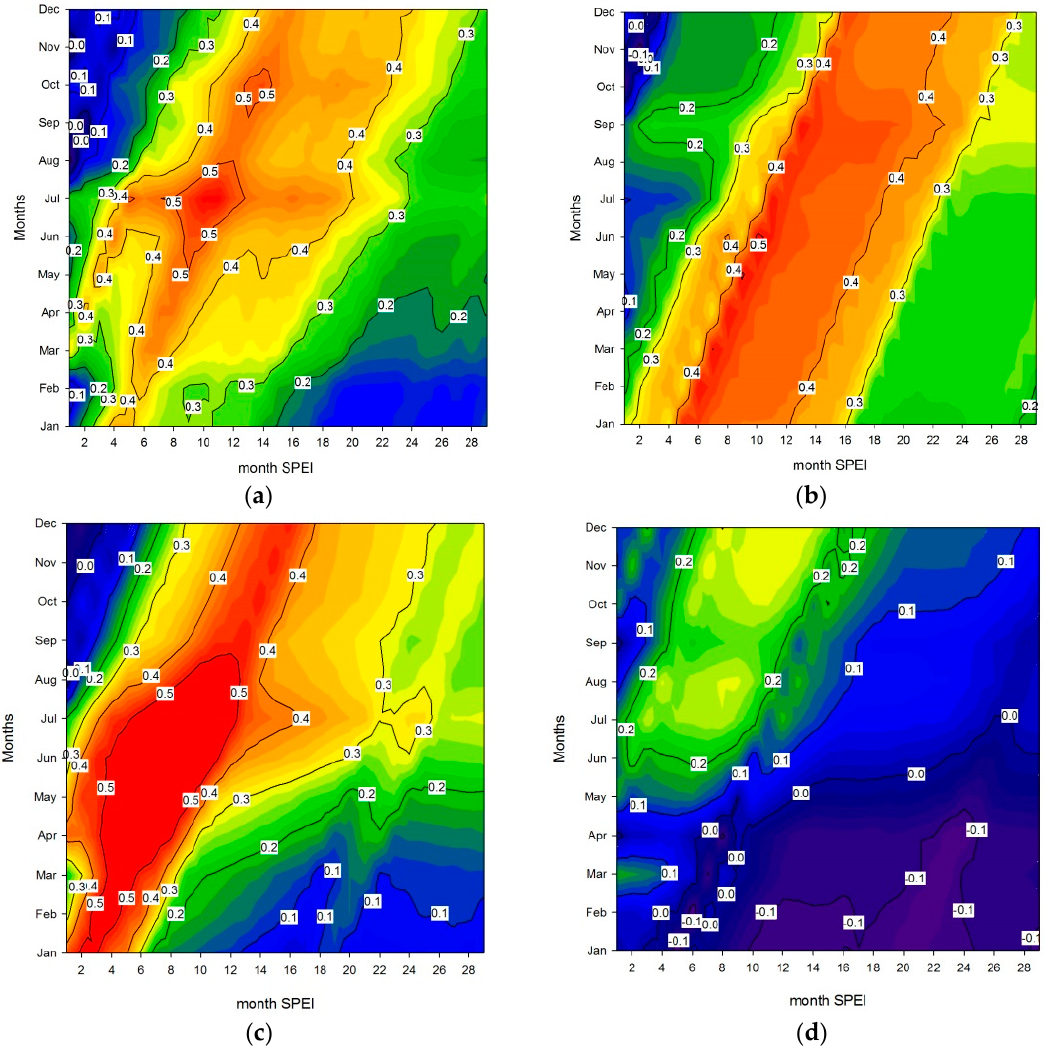
Figure 4. Correlations between the Standardized Precipitation Evapotranspiration Index (SPEI), and the residual chronologies of ring-width indices. Arizona ( a ), California Sur ( b ), Nuevo León ( c ), and Puebla ( d ). The SPEI was calculated at a scale of one to 28 months from January to December of the growth year ( x axes). The Pearson correlation coefficients ( r ) are indicated using color scales.